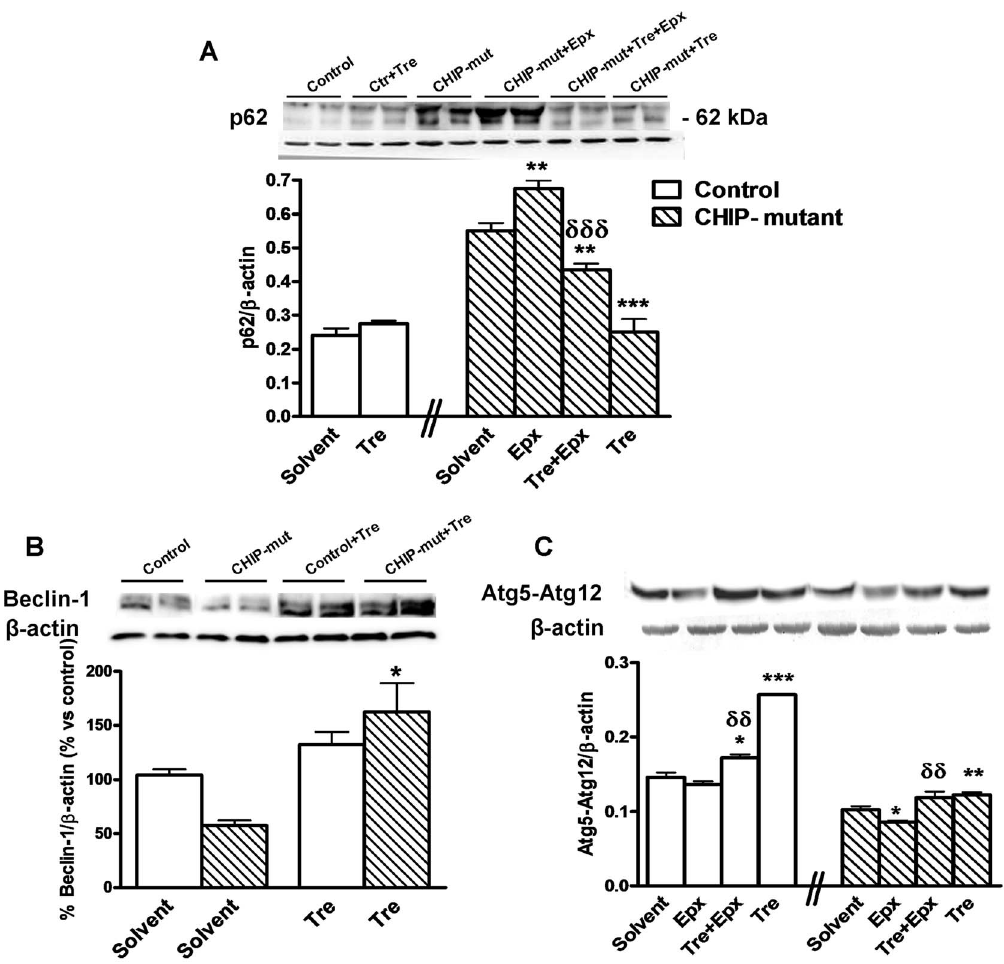
Figure 6. Expression of p62, Atg5–Atg12 and Beclin-1 in controls and CHIP-mutant fibroblasts. Trehalose treatment increases the autophagic activity. Fibroblasts were exposed to 50 mM trehalose for 24 hours and the autophagy-related proteins were analyzed by Western blot. A ) Western blot showing the autophagic degradation of p62, a major selective substrate for autophagy. B ) Beclin-1 and C ) Atg5-12, essential factors for autophagosome formation were increased by trehalose. Data of the control and CHIP-mutant groups were analyzed independently, no inter- group statistical analysis was performed. Data are expressed as the mean 6 SEM. Values are the mean of two experiments of independent dishes of one patient (pseudo-replicates, n=4–6) and for control group 3 different controls with the mean of different dishes of cells (n=3). Statistical analysis was performed by Student’s t-test. *p , 0.05, **p , 0.01, ***p , 0.001 vs solvents; dd p , 0.01, ddd p , 0.001 trehalose + epoxomicin vs epoxomicin treated